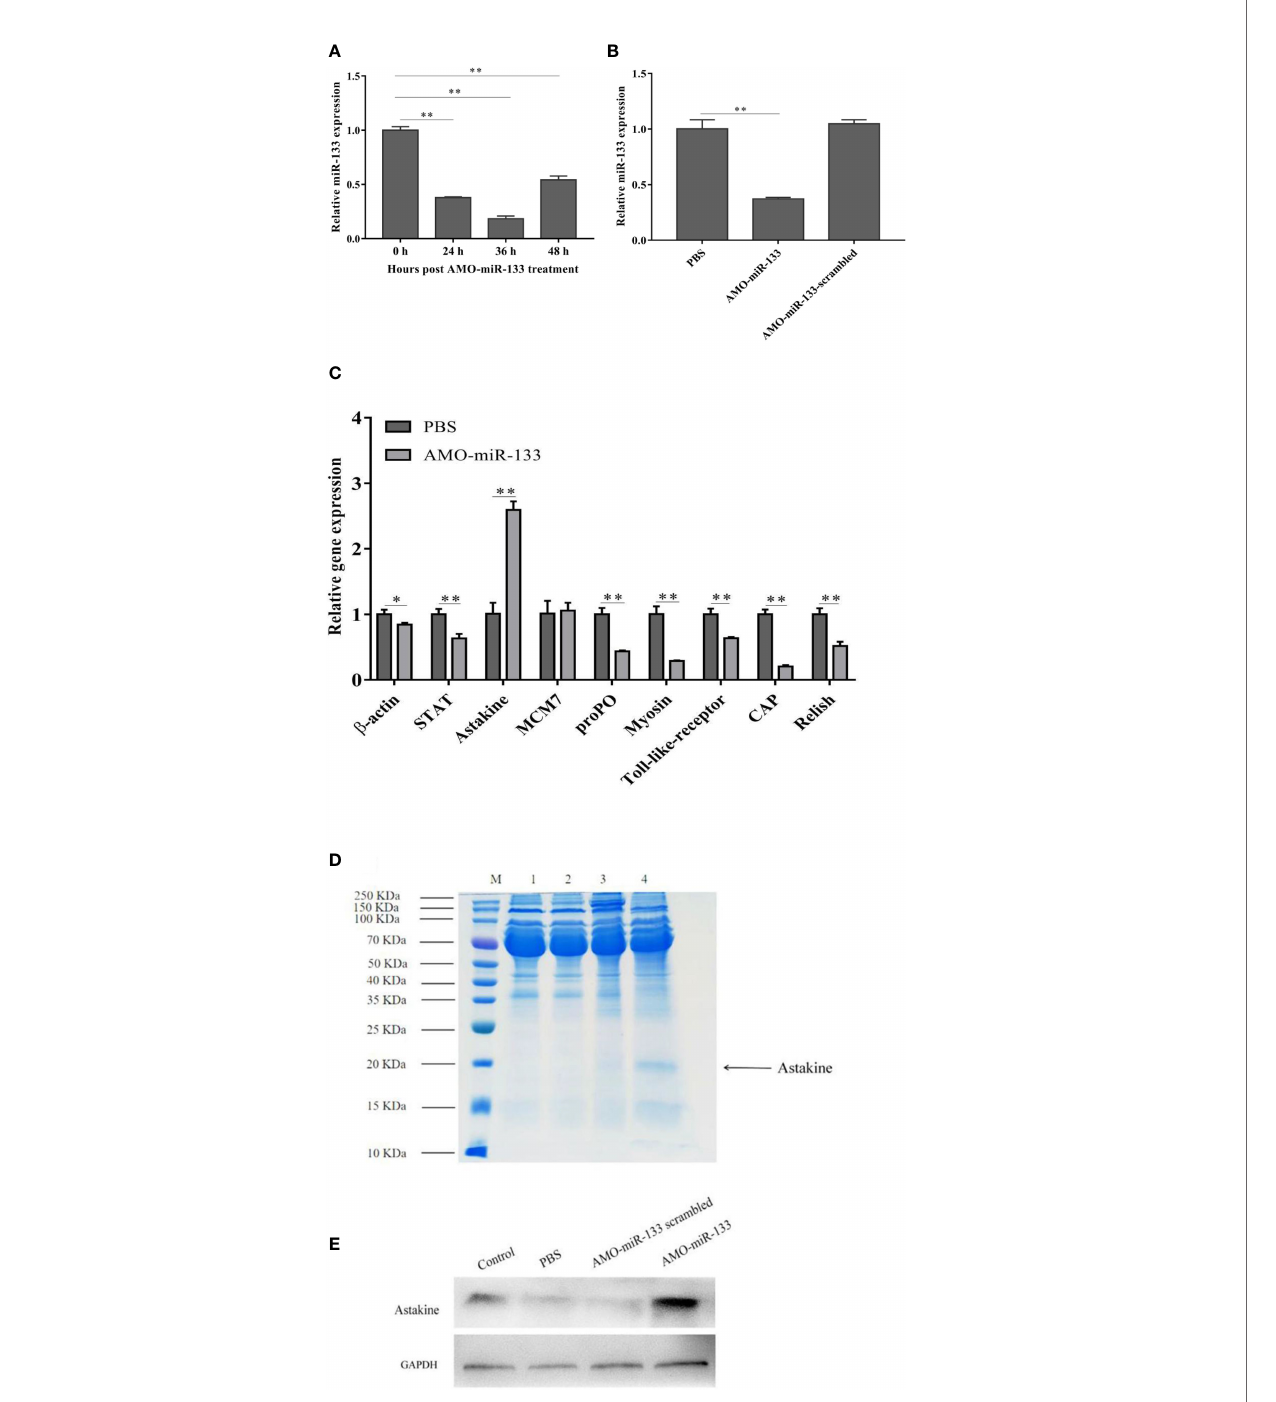
FIGURE 2 | Knockdown of miR-133. The miRNA of healthy, AMO-miR-133-scramble-treated or AMO-miR-133-treated S. paramamosain was extracted from hemocytes. (A, B) Expression levels of miR-133 in hemocytes of S. paramamosain detected by RT-qPCR, (A) (24 h P =0.000028, 36 h P = 0.000014, 48 h P = 0.00020), (B) AMO-miR-133 P = 0.000028, AMO-miR-133 scrambled P = 0.26. (C) Relative expression of nine immune-related genes ( b -actin (P = 0.021), STAT (P = 0.0011), astakine (P = 0.00021), MCM7 (P = 0.75), proPO (P = 0.00053), myosin (P = 0.00050), Toll-like receptor (P = 0.00050), CAP (P = 0.000057), Relish (P = 0.0017) ) after AMO-miR-133 treatment. (D) Mud crabs were treated for 24 h with the indicated concentration of AMO-miR-133, then the cell lysate was prepared for SDS-PAGE (M: Marker; 1: Control; 2: PBS; 3: AMO-miR-133 scrambled; 4: AMO-miR-133) or (E) western blot analysis. Mud crab GAPDH was used as the control. Data presented were the mean ± standard deviation of three independent experiments. Signi fi cant difference between different samples is indicated by * P < 0.05 and ** P <